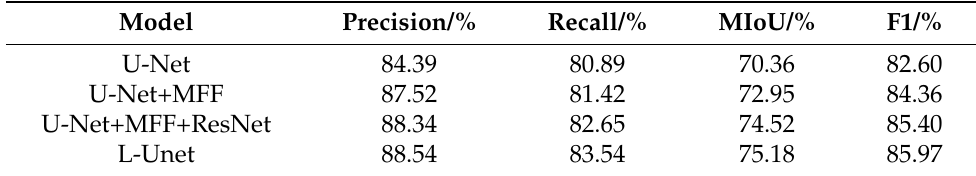
Figure 6. ( a ) Part of the landslide images for the test set and ( b ) extraction results of the L-Unet model. Table 1. Comparison of the performance before and after